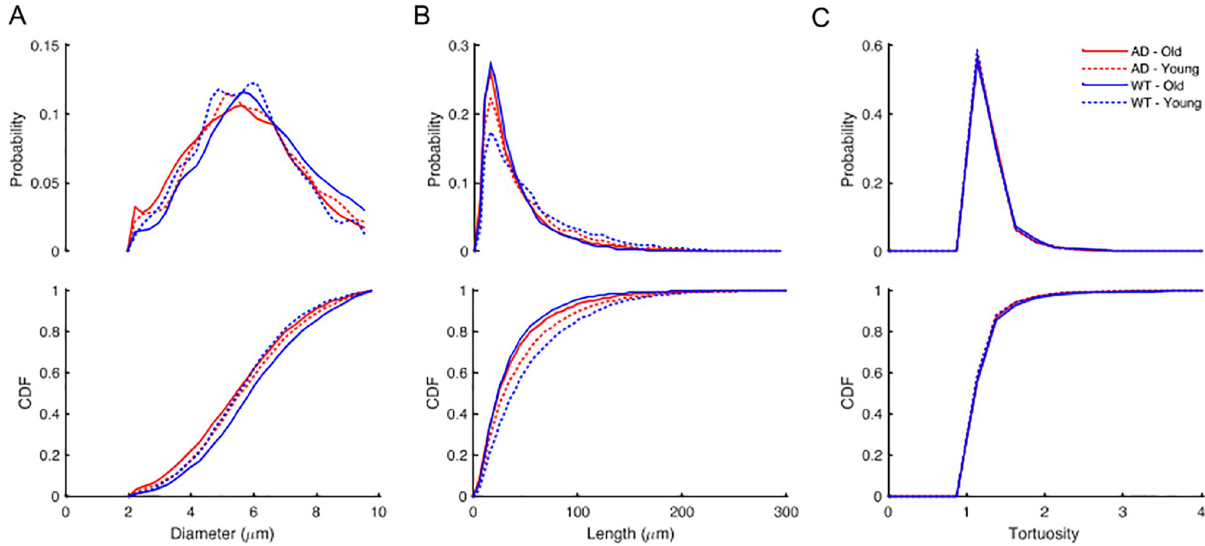
Fig 7. Comparison of capillaries between young and old mice with WT and AD genotype (6 mice in each group). The relative probability and cumulative distribution function (CDF) of the (A) diameters, (B) length, and (C) tortuosity based on all capillaries aggregated within each of the four groups. We compared these metrics between the groups using Kruskal-Wallis test followed by Bonferroni multiple comparison correction [54] (Table 2).